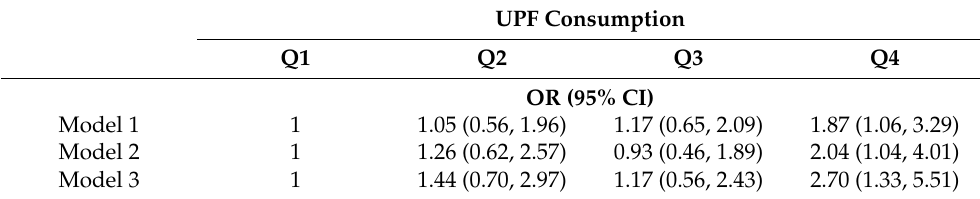
Table 3. Association between intake of UPFs and having depressive symptoms in the study